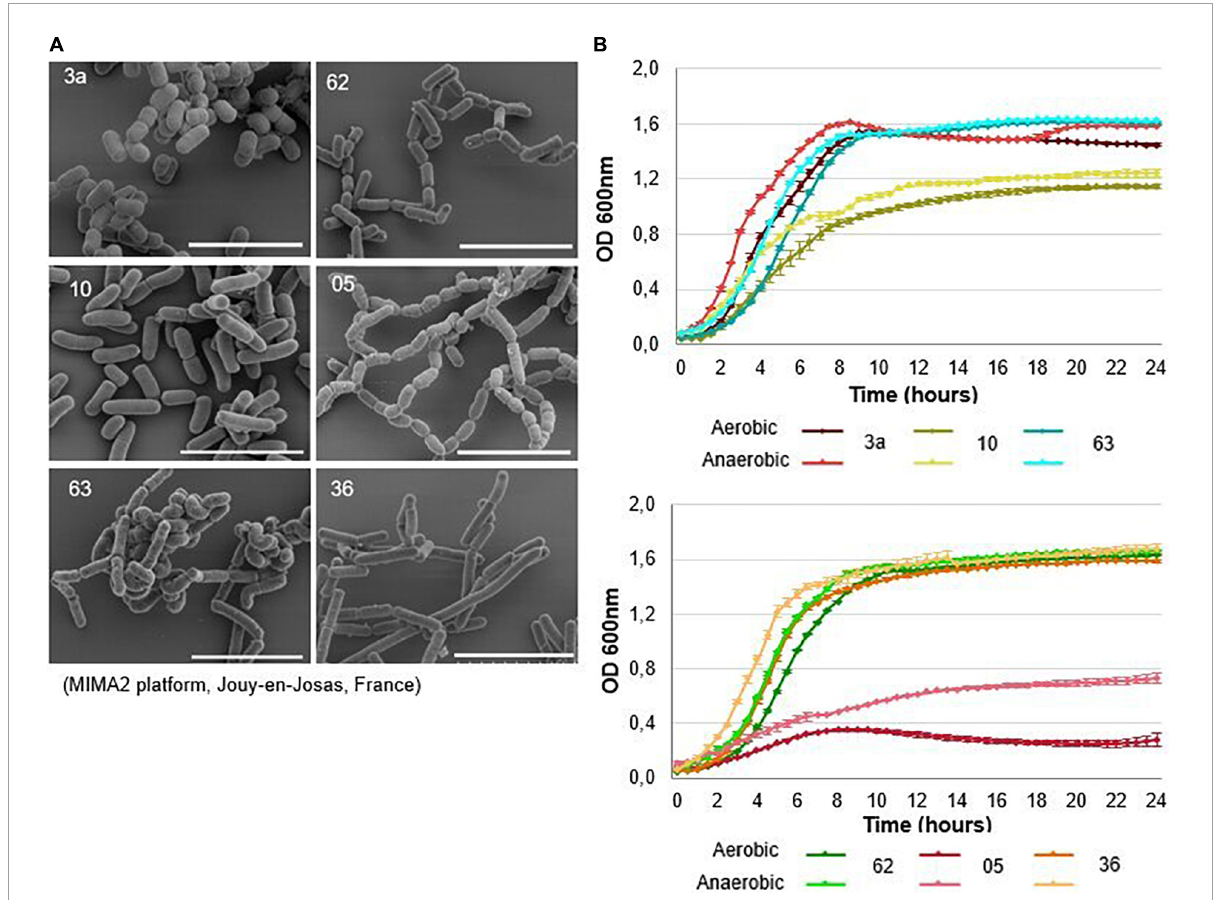
FIGURE3 Description of lactic acid bacteria selected for further testing. (A) Scanning electron microscopy images and (B) growth curves of the six bacterial strains selected. Bacteria were grown in MRS medium under aerobic conditions (dark-colored curves) and anaerobic conditions (light-colored curves) for 24 h at 37 ◦ C. Growth was measured using optical density (OD) at 600 nm. Anaerobic conditions were achieved by completely covering the wells with paraffin oil. The mean ± SEM of three wells are shown. The scale bars represent 5 µ